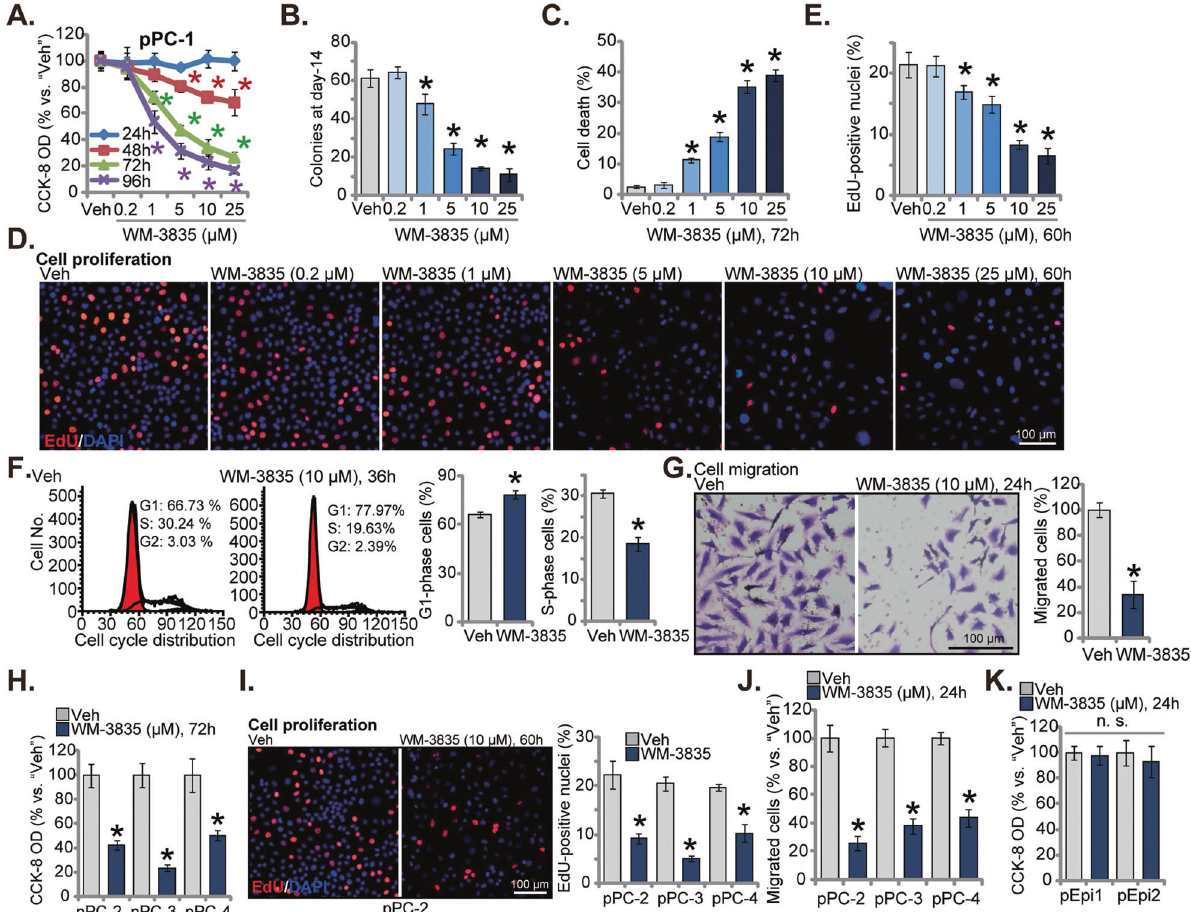
Fig. 1 WM-3835 inhibits primary CRPC cell viability, cell cycle progression, proliferation and migration in vitro. The primary human prostate cancer cells derived from a CRPC patient, “ pPC-1 ” , were treated with WM-3835 (at designated concentrations) or vehicle control ( “ Veh ” ) for designated hours, cell viability (CCK-8 assay, A ), colony formation ( B ), cell death (by testing medium LDH releasing, C ) and proliferation (by testing EdU incorporation, D and E ), as well as cell cycle distribution ( F ) and in vitro cell migration ( G ) were tested.